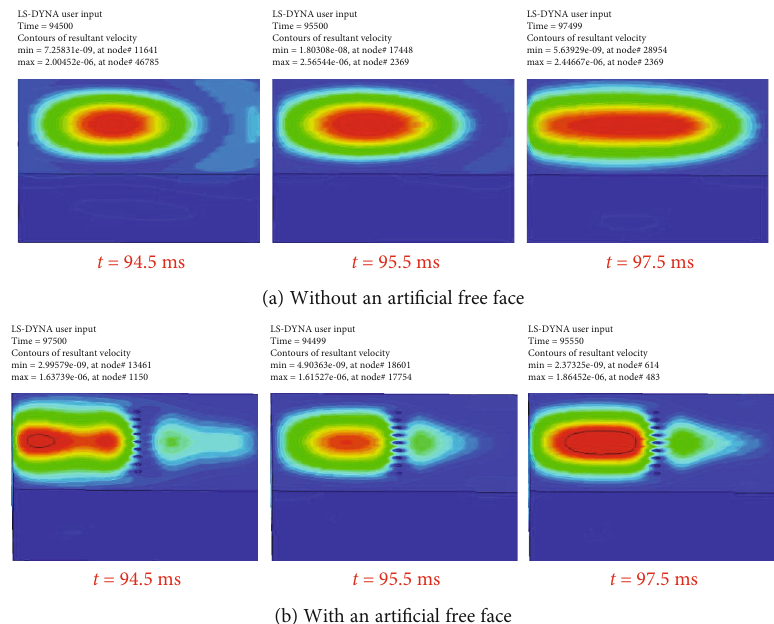
Figure 14: Surface velocity cloud images of the vibration (unit: ms).